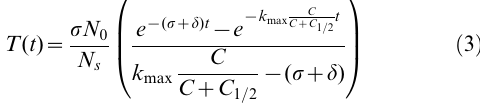
Table 1. Estimates of killing rates based on a model with a saturating killing term for in vivo CTL killing data.